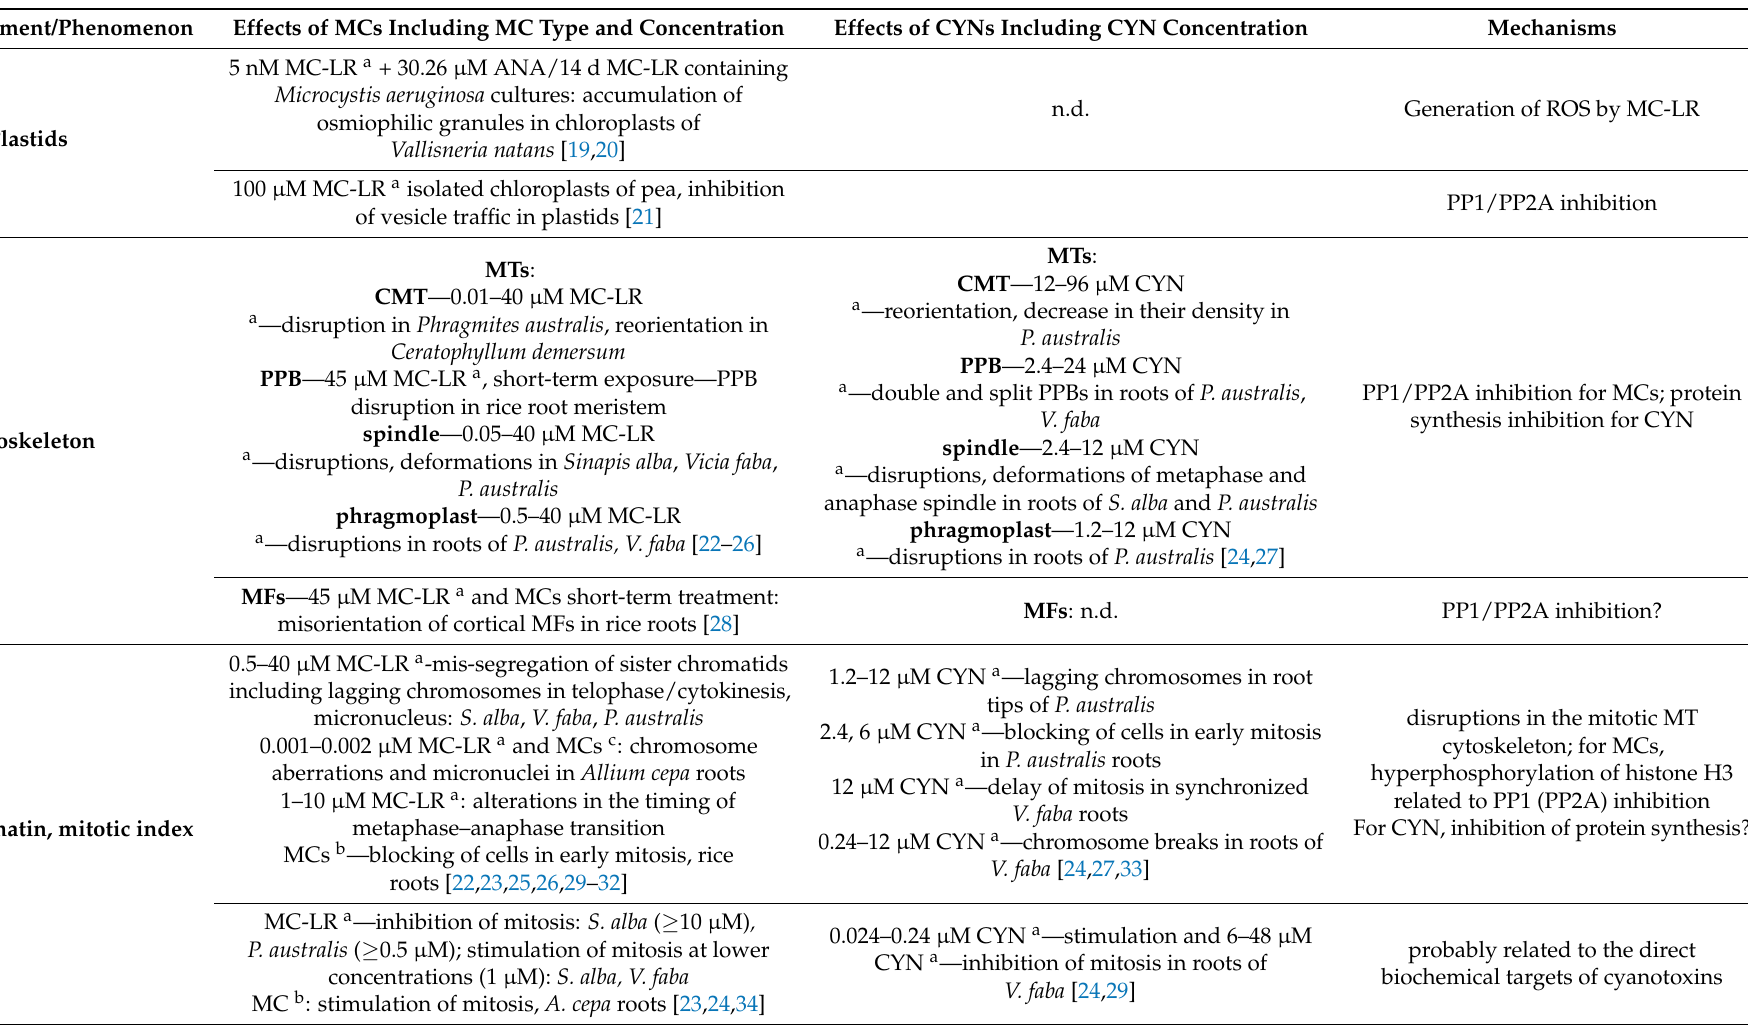
n.d. Generation of ROS by MC-LR PP1/PP2A